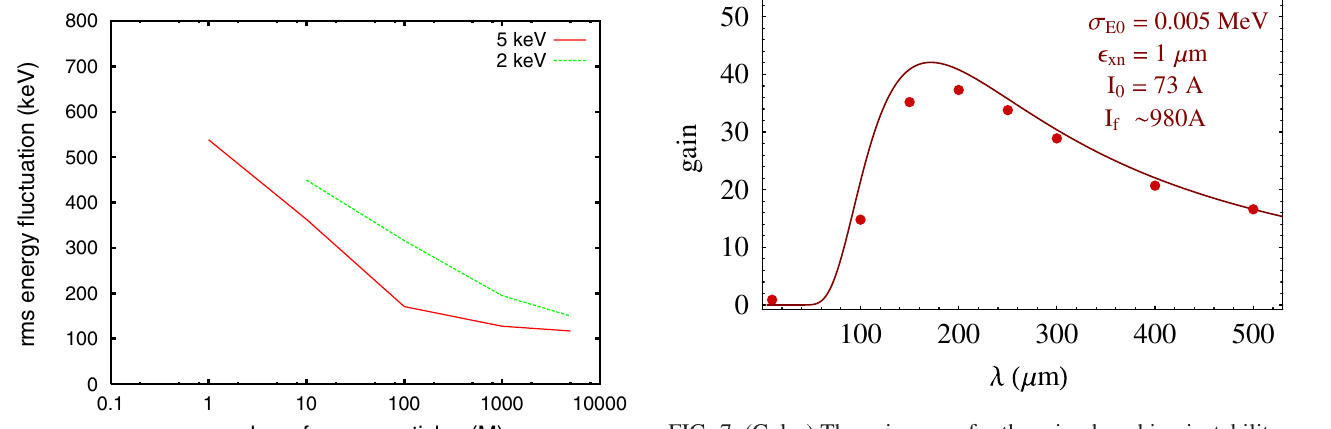
FIG. 7. (Color) The gain curve for the microbunching instability through a portion of beam line considered in our studies for an FEL linac at LBNL (see text). Linear theory (solid line) is compared to results from macroparticle simulations (dots). The reported value of (cid:9) is for the modulation wavelength before compression.